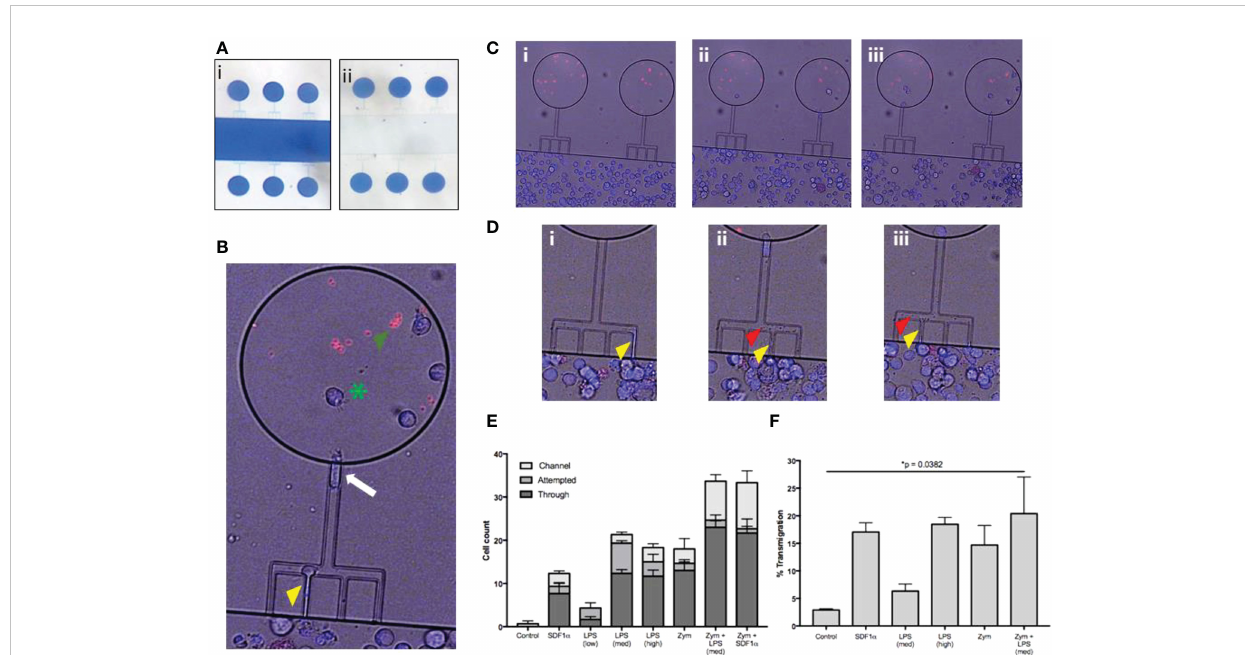
FIGURE 3 Meg-01 cells are capable of chemotaxis to pathogenic stimulus. Meg-01 cells were tested for their ability to chemotax towards LPS and zymosan particles. (A) A micro fl uidic device was used for part of the chemotaxis experiments. In this device, the main channel is connected to a circular reservoir by four 6 µm wide channels and a larger 8 µm wide connecting channel in a comb-like arrangement. The device is fi rst primed with the condition (panel i) and the main channel is then fl ushed with media in order to create a concentration gradient from the chemoattractant chambers into the main channel (panel ii). (B) The MKs were stained with Hoechst for positive identi fi cation and then manually tracked. The behavior of the MKs was divided into 3 categories: cells attempting to enter the channel (yellow arrowhead), cells inside the channel (white arrow), and cells through the channel and inside the reservoir (green arrowhead). Zymosan particles are marked with a green asterisk. (C) Time lapse image of MKs migrating into chambers primed with LPS (360 pg/mL) and zymosan particles ( Ci , no cells in the chambers with the red zymosan particles; (Cii) , cells starting to migrate up the combs into the zymosan chambers; (Ciii) fi nal timepoint with multiple cells in each zymosan chamber). (D) Close-up of time-lapse imaging where MKs were observed attempting to enter the channel, extend a portion of the cell into the side channel (yellow arrowhead) (Di – Diii) , and then bud off small platelet-like particles (red arrowhead) (Dii, Diii) . Additionally, a single MK is followed shown throughout this timelapse fi rst entering the comb (Di) and then fi nally entering the chamber (Diii) . (E) Bar graph representing MK chemotaxis within the micro fl uidic device. (F) Bar graph representing MK chemotaxis in a transwell assay, con fi rming the observations made with the micro fl uidic device. Statistical analysis for (E, F) are One-way ANOVAs with results in detail in Figure S4. LPS low, 22 pg/mL; LPS med, 220 pg/mL; LPS high, 2.2 ng/mL; Zym, zymosan particles; Zym+LPS, zymosan particles with 220 pg/mL LPS. Bar graphs are mean with standard error